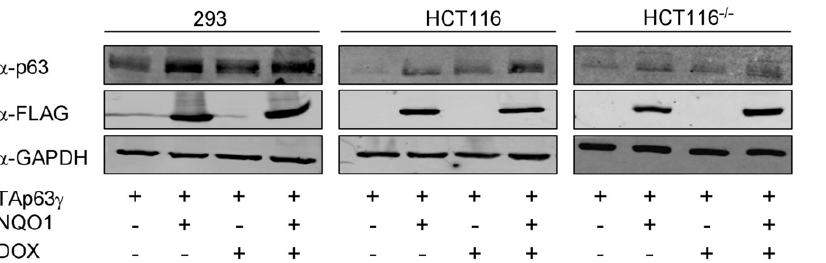
Figure 2. TAp63 c expression is stabilized by NQO1 in response to genotoxic stress. 293, HCT116 and HCT116 2 / 2 cells expressing endogenous NQO1 or over-expressing wild-type FLAG-NQO1 were transfected with a plasmid expressing TAp63 c . Twenty-four hours post- transfection cells were treated with 1 m M DOX for 24h. At this point, cell lysates were prepared and resolved by SDS-PAGE. TAp63 c , NQO1 and GAPDH levels were detected by Western blot analysis using anti-p63 (4A4), anti-FLAG and anti-GAPDH (loading control) antibodies, respectively.